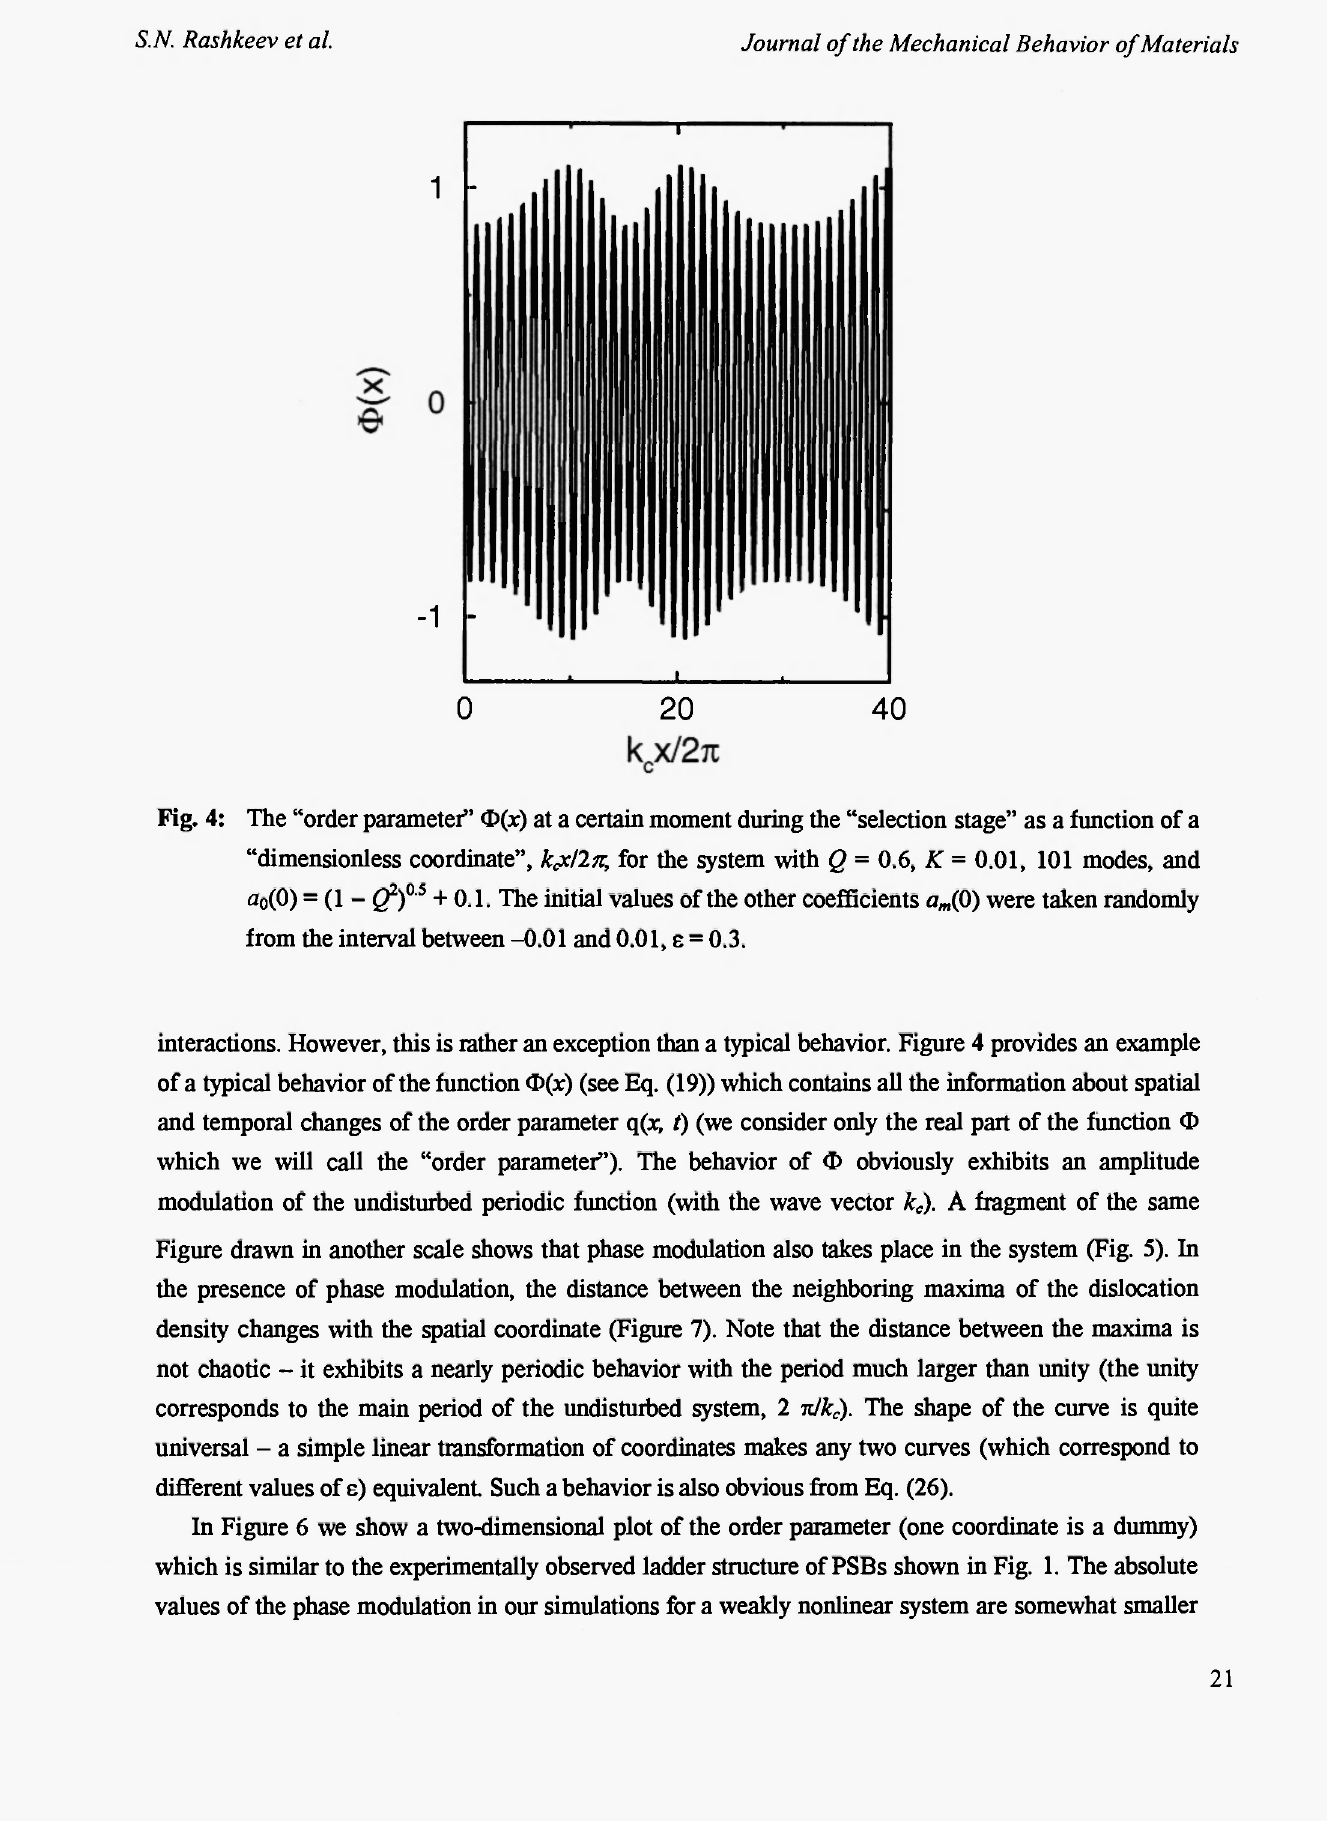
Fig. 4: The "order parameter" Φ(χ) at a certain moment during the "selection stage" as a function of a "dimensionless coordinate", kjc/2π, for the system with Q = 0.6, Κ = 0.01, 101 modes, and a (0) = (1 - Q 2 ) 0 5 + 0.1. The initial values of the other coefficients a 0 from the interval between -0.01 and 0.01, ε =